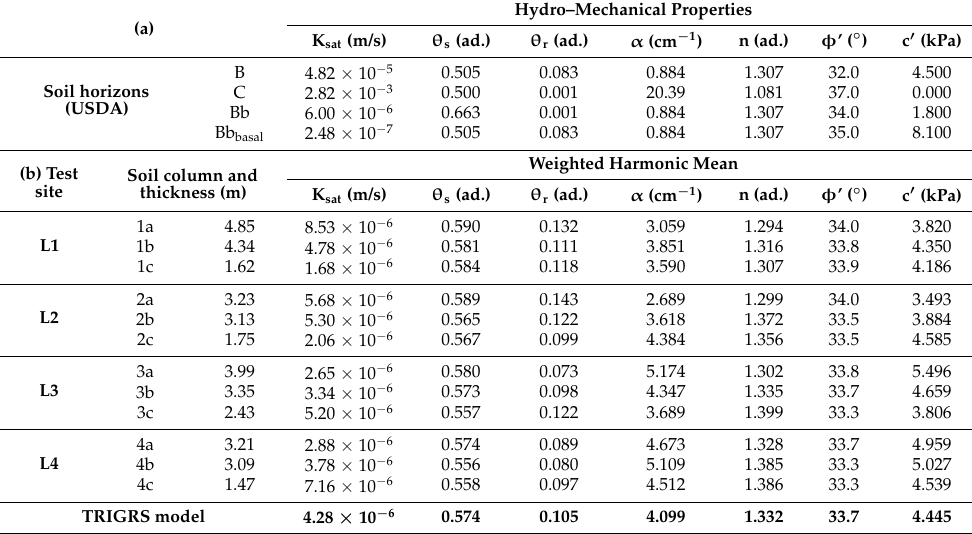
Table 1. (a) Unsaturated and saturated hydraulic and geotechnical soil properties determined for principal ash-fall pyroclastic soil horizons [76,77]; (b) Unsaturated/saturated hydraulic and geotechnical soil properties used for setting TRIGRS model and derived as median value of weighted harmonic means (WHM), estimated for 12 representative soil columns of four test sites (L1, L2, L3, L4) [76,77]. Keys to symbols: (K sat ) saturated hydraulic conductivity; ( θ s ) saturated volumetric water content; ( θ r ) residual volumetric water content; ( α and n) van Genuchten’s fitting parameters of soil water retention curve; ( φ ’) = effective friction angle; (c’) = effective